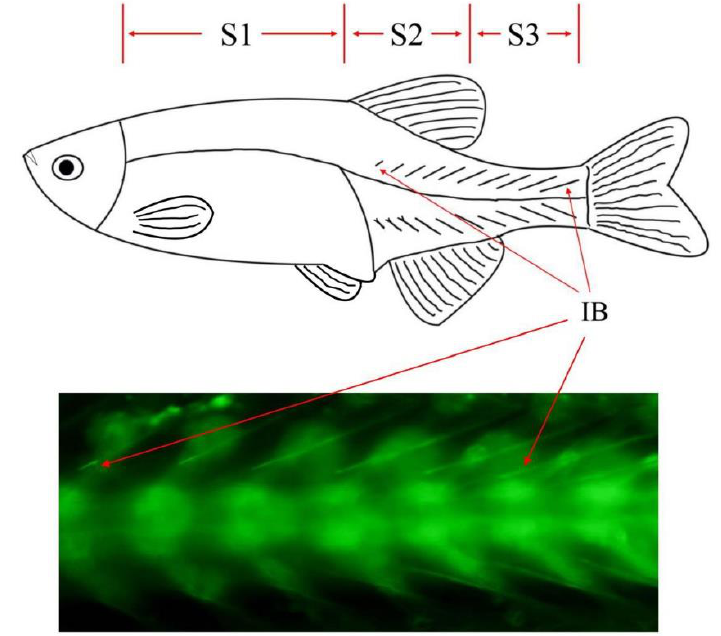
Figure 1. Phenotypic characteristics and sampling scheme of zebrafish IBs.